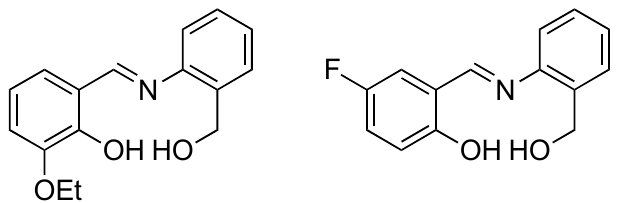
Figure 1. Chemical Structures of the Ligands H 2 L 1 (left) and H 2 L 2 − (right); the doubly deprotonated ligands bind to the Ni II ions of the cluster cores.